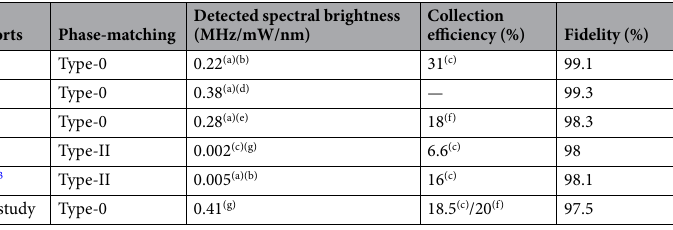
Table 1. Comparison of the performance parameters of the SPDC sources based on PPKTP crystals. (a) Non- degenerate photons, (b) Sagnac interferometer, (c) single mode fiber, (d) double-pass, (e) two crystals, (f) multimode fiber, (g) single-pass degenerate